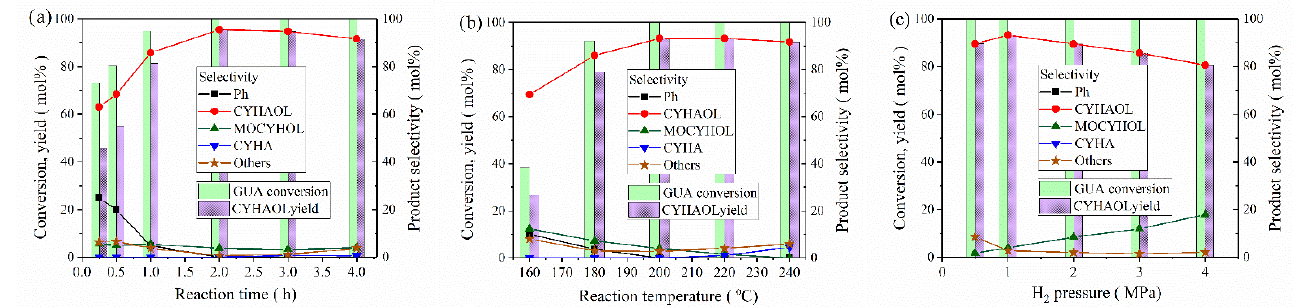
Figure 7. Influence of ( a ) reaction time, ( b ) reaction temperature, and ( c ) H 2 pressure on the HDO of GUA (Reaction conditions: 300 mg of GUA in 10 mL of n-dodecane, catalyst loading = 30 mg. Other conditions: ( a ) 200 °C, 1 MPa H 2 ; ( b ) 1 MPa H 2 , 2 h; ( c ) 200 °C, 2 h).